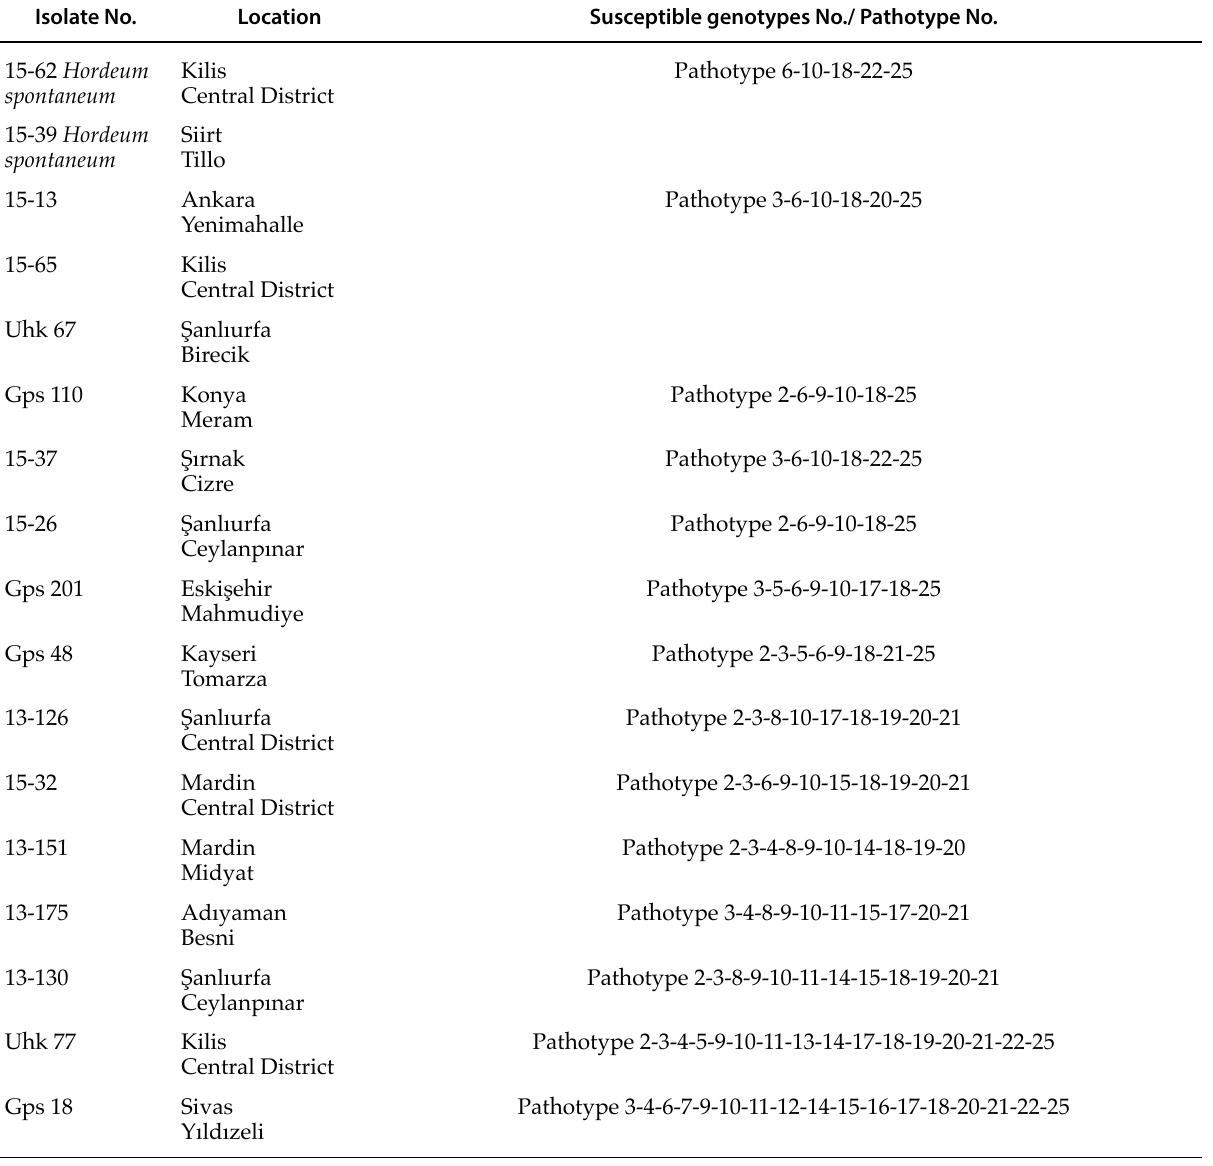
NDB 112, five isolates (10%) on genotype FR